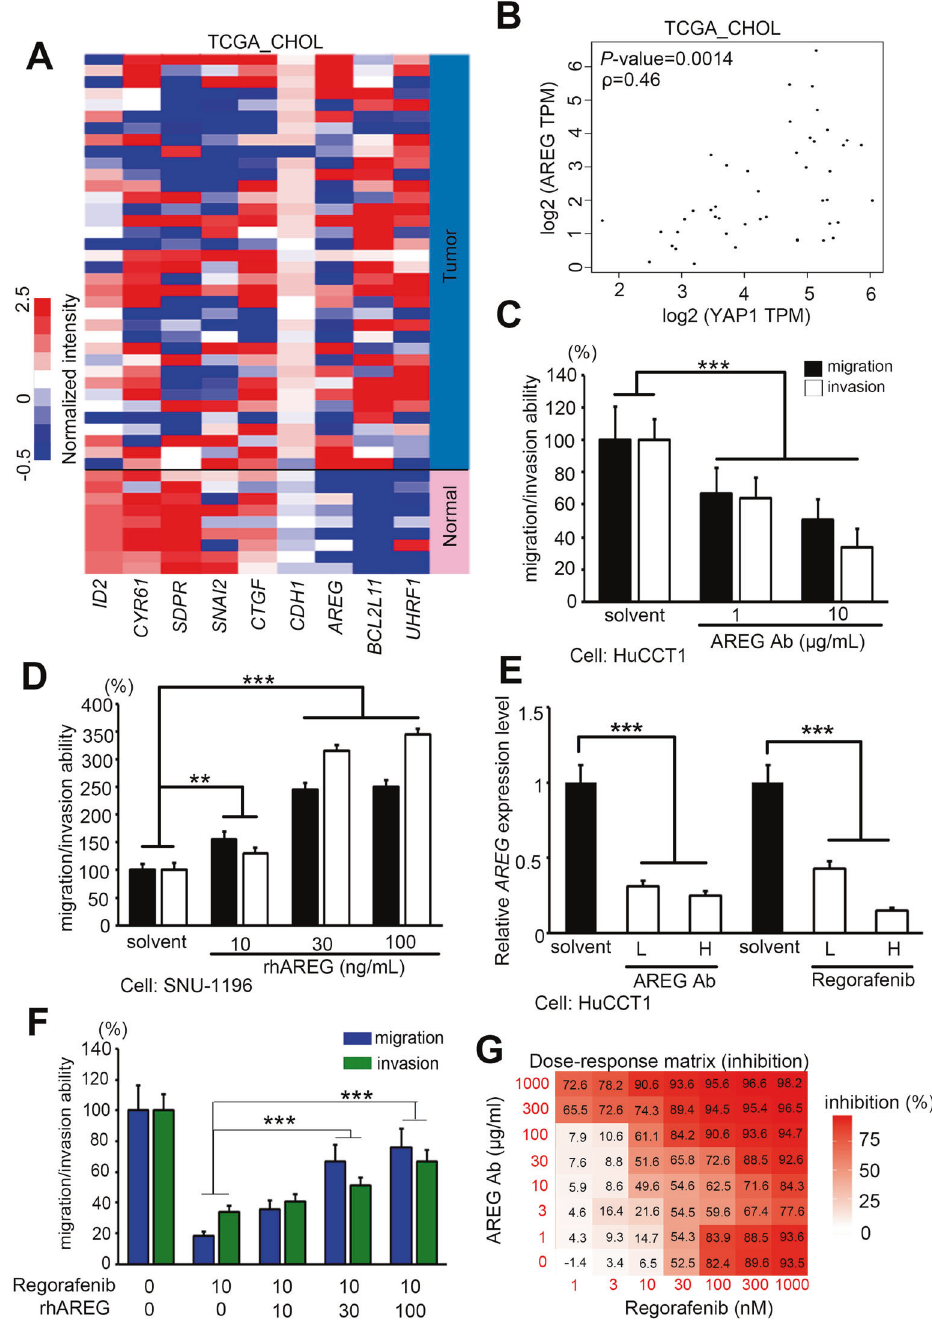
Fig. 6 YAP1 modulates migration/invasion capability through downstream target AREG. A Heat map of the expression of YAP1 downstream genes from the TCGA RNA sequencing database in noncancerous and tumor tissues derived from CCA patients. B Correlation between YAP1 and AREG mRNA levels in TCGA_CHOL clinical patients ( ρ = 0.46, p = 0.0014). C Treatment with anti-AREG antibody suppressed the invasive ability of HuCCT1 cells. Cells treated with anti-AREG antibodies (1 and 10 µg/mL) were seeded into the upper well of the Boyden chamber with Matrigel and subjected to invasion assays for 18 h. The columns represent mean values from three independent experiments. Bars: means ± SD. D AREG recombinant protein treatment increased the invasive ability of SNU-1196 cells. Cells with AREG recombinant protein (10, 30, and 100 ng/mL) were seeded into the upper well of the Boyden chamber with Matrigel and subjected to invasion assays for 18 h. The columns represent mean values from three independent experiments. Bars: means ± SD. E qRT-PCR analysis of AREG mRNA expression in HuCCT1 cells treated with AREG neutralize antibody or regorafenib. F Quantitation of migration/invasion ability of HuCCT1 treated with regorafenib (10 μ M) with or without combined AREG recombinant protein (10, 30, and 100 ng/mL). G Calculate the synergy of the combined use of regorafenib and AREG neutralize antibody through the SynergyFinder service. Data are presented as the mean of three independent experiments ± SEM. The signi fi cance of the difference was determined using a nonparametric Mann – Whitney U -test. * p < 0.05, ** p < 0.01, *** p < 0.001.